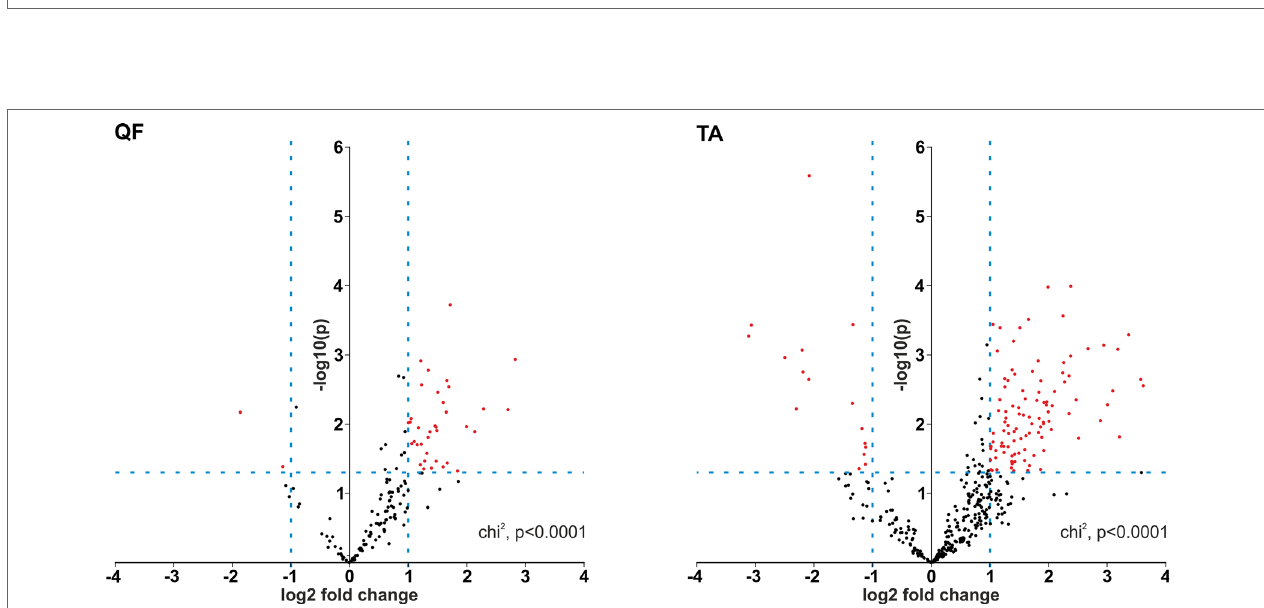
FIGURE 3 | Comparison of cumulative levels of circRNAs and linear RNAs in control and myotonic dystrophy type 1 (DM1) muscle samples. Dot plots depicting the cumulative level of “common” circRNAs and linear transcripts in quadriceps femoris (QF) (upper panel) and tibialis anterior (TA) (lower panel). From the left (in each panel): cumulative reads per million mappable reads (RPM) of circRNAs, cumulative RPM of linear transcripts, and cumulative fraction of circRNA-specific reads in a total number of circRNA-specific and corresponding linear reads (FCR). The false discovery ratio (FDR)-corrected p -value ( t -test with correction for not-equal variance) of the differences between control and DM1 samples is shown above each dot plot.